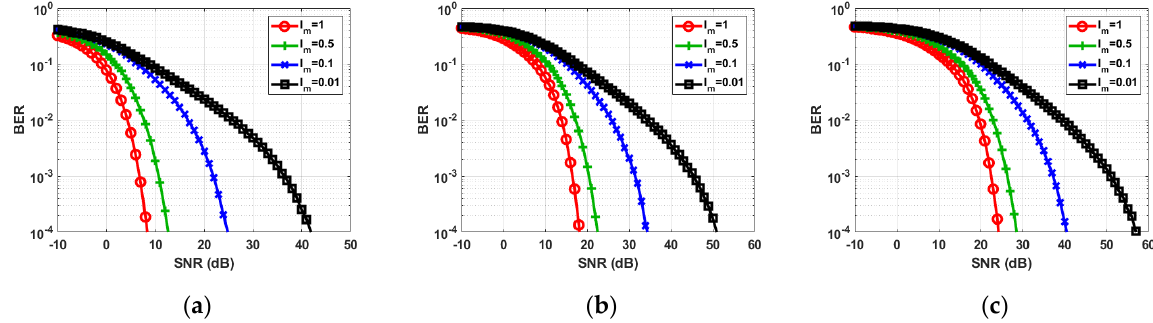
Figure 10. BER simulation results (fixed I p and varying I m ) for ( a ) QPSK, ( b ) 16QAM, and ( c ) 64QAM.